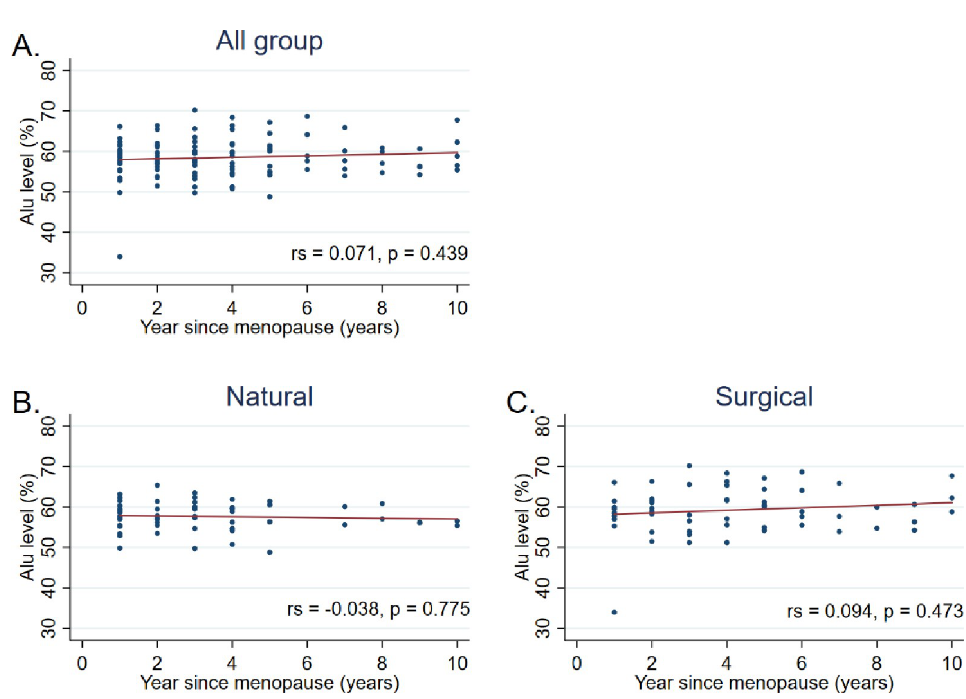
Fig 3. Correlation between the Alu methylation level and time-since-menopause among A) all participants, B) natural menopause group, and C) surgical menopause group. Data were analyzed using Spearman’s correlation analysis.